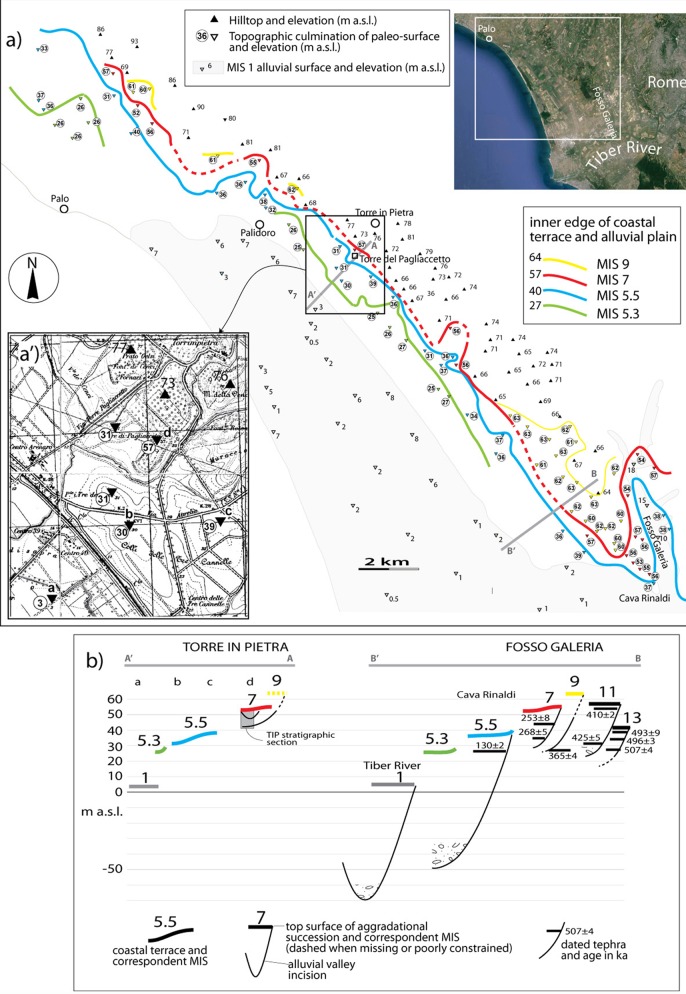
Reconstruction of the coastal terraces and their inner edges in the sector north of the Tiber mouth.a) The reconstruction is based on mapping of a set of flat surfaces identified by topographic points (triangles) selected on the 1:25.000 topographic base, as in the detail of inset a') and following criteria described in the text. b) Cross section A-A' shows the morpho-stratigraphic setting in Torre del Pagliaccetto through the coastal plain with elevation of the terraced surfaces correlated with the high stands of marine isotopic stages (MIS). Composite cross-section B-B' shows the complete suite of aggradational successions and related terraced surfaces in the Fosso Galeria area, whose correlation with the different MISs is provided by 40Ar/39Ar ages of intercalated tephra layers and morpho-stratigraphic relationships [5, 18, 31]. The inset top right is a satellite image from Google Earth. Inset a' is modified from the 1:25 000 topographic map of the Istituto Geografico Militare d’Italia, Foglio 149, survey of 1949.